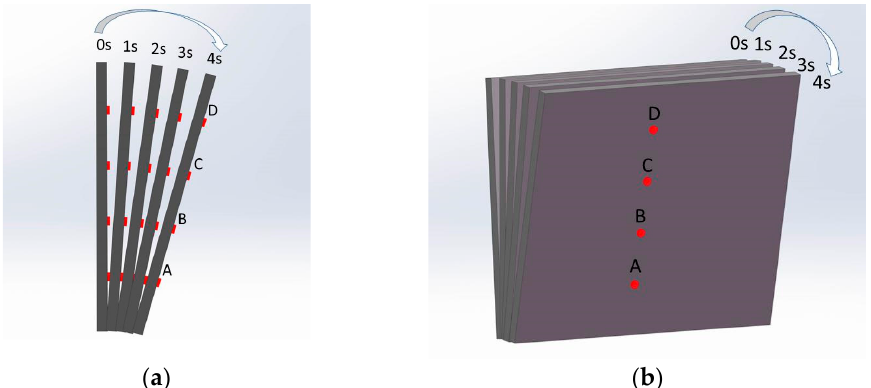
Figure 12. The dynamic displacement map of the microchip over time: ( a ) left view; ( b ) front view.